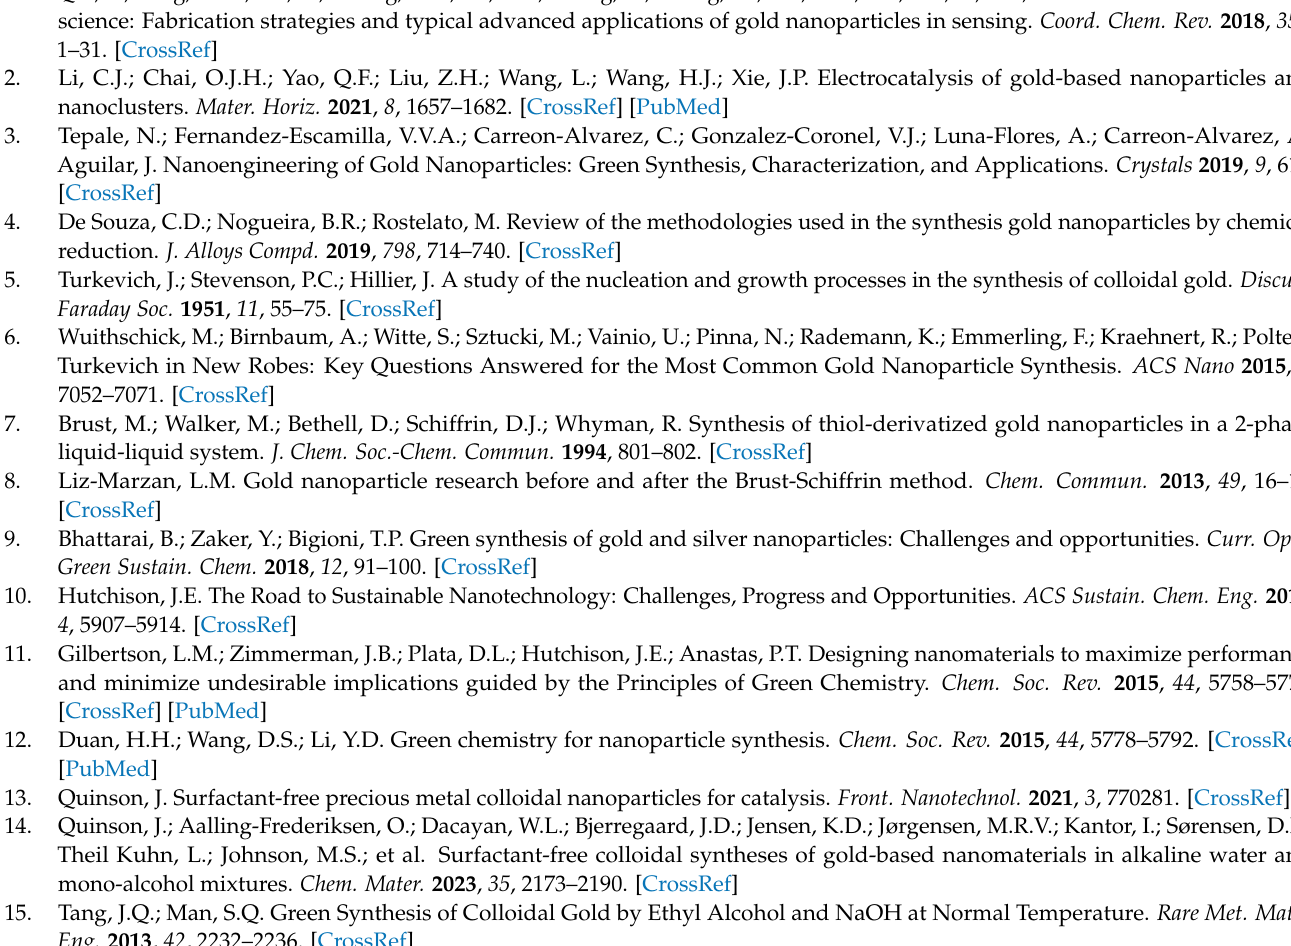
Table S3: Effect of using fresh or aged stock solutions of base for the synthesis of Au NPs using additives; Figure S1: UV-vis characterization of Au NMs obtained by surfactant-free RT synthesis using 30 v.% ethylene glycol as reducing agent prepared using a fresh or an old stock solution of NaOH. Reference [14] is cited in the supplementary